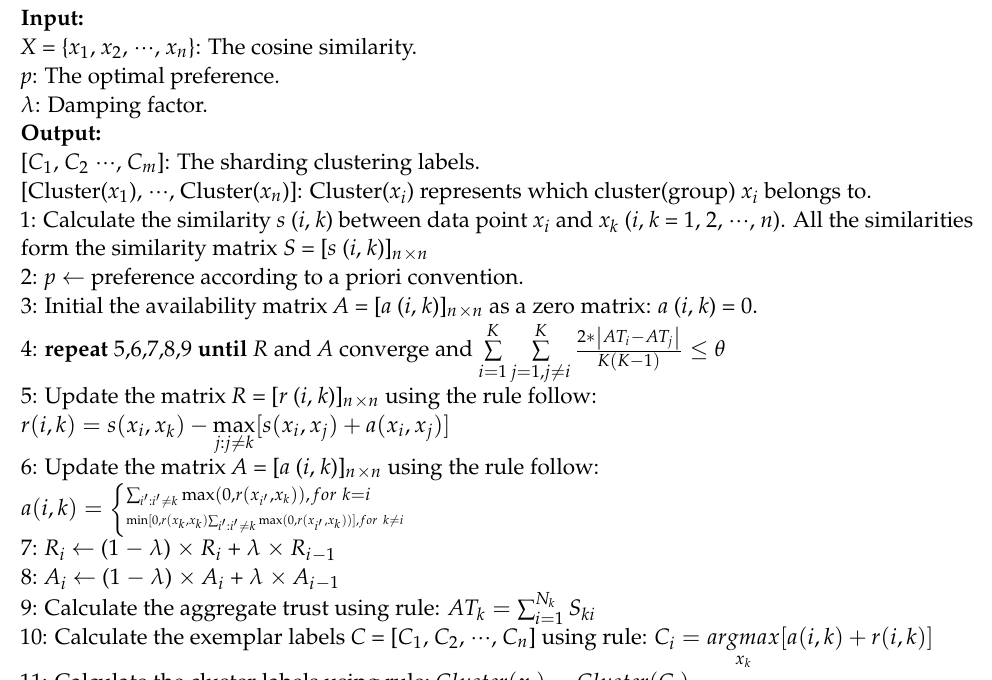
Algorithm 1. AP (Affinity Propagation)